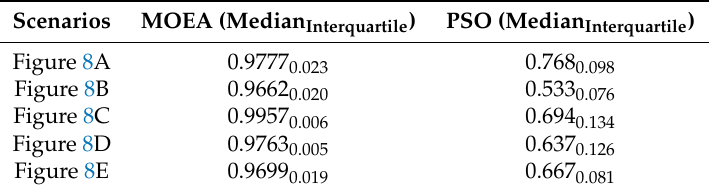
Table 2. The results of the hypervolume median and interquartile